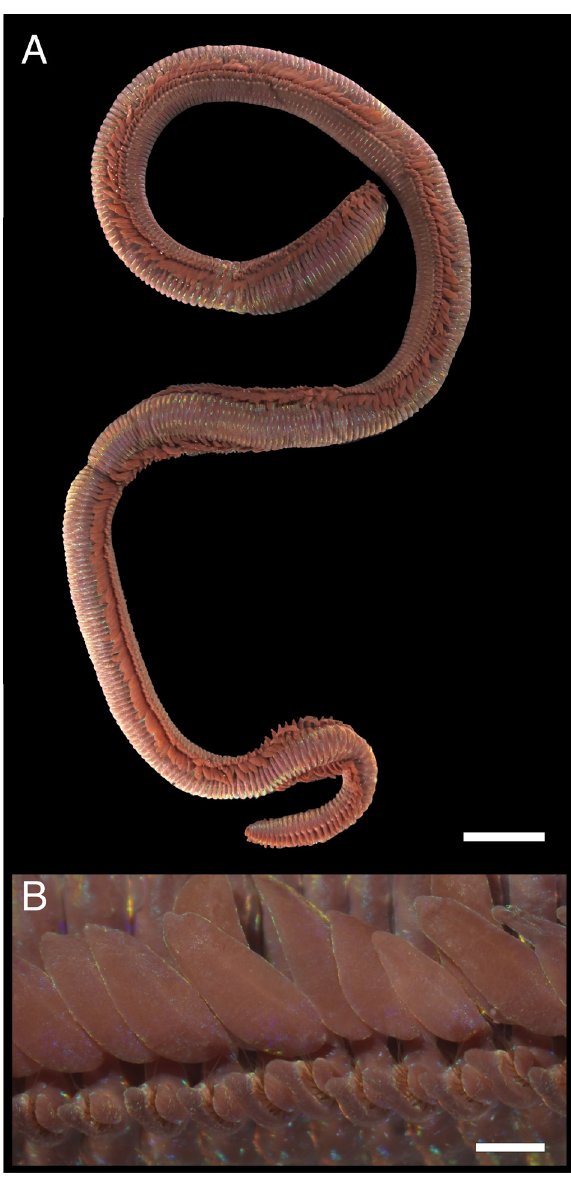
Figure 2. A fragmented specimen of Halla okudai collected from Tomie Bay in the Goto Islands, Japan. A. Lateral to dorsal view of the specimen. B. Parapodia of the specimen. Scale bars: A = 10 mm; B = 1